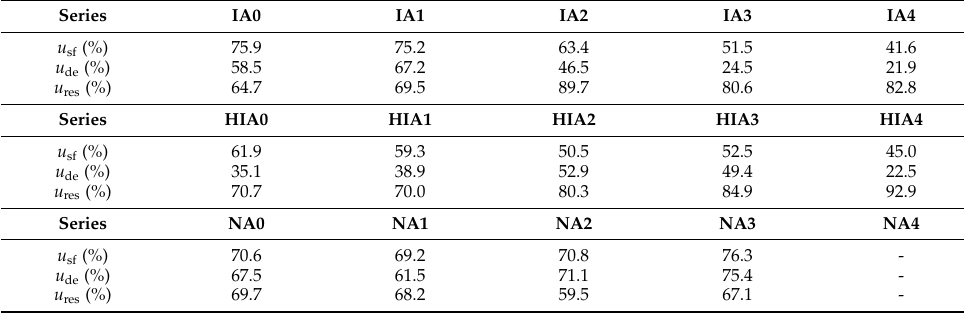
Table 4. The nominal strength